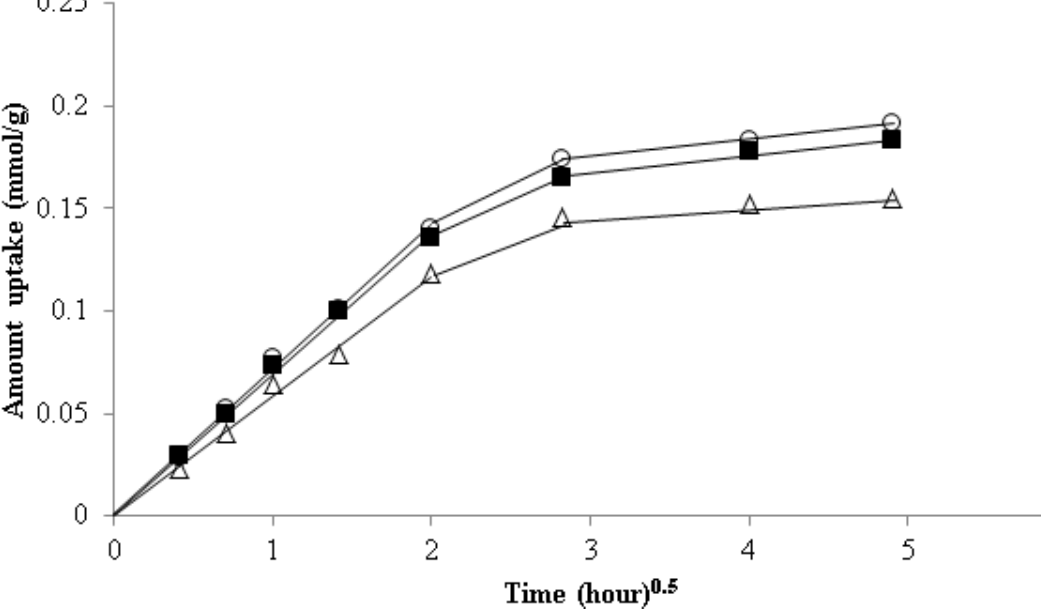
Figure 9. Intra-particle rate constant for strontium uptake onto the CF beads at temperatures: ( ○ ) 293 K, ( ■ ) 298 K, and ( ∆ ) 308 K.